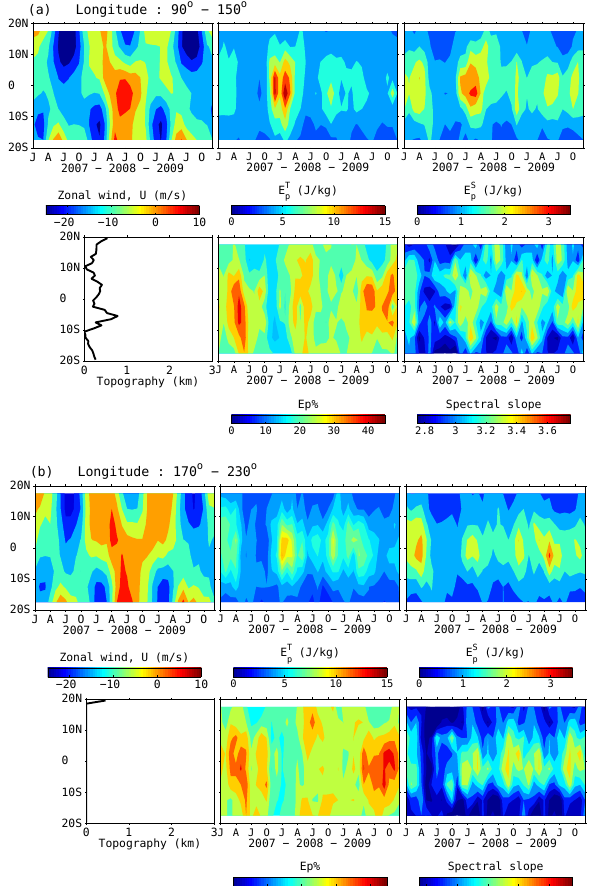
Figure 7. Same as Fig. 6 except in the tropics at 20 ◦ S–20 ◦ N.